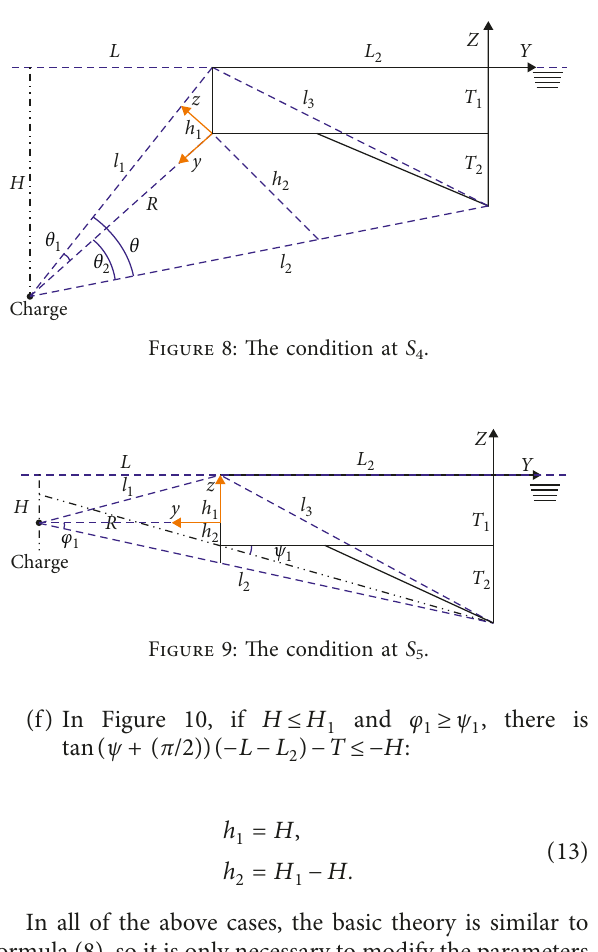
Figure 10: The condition at S